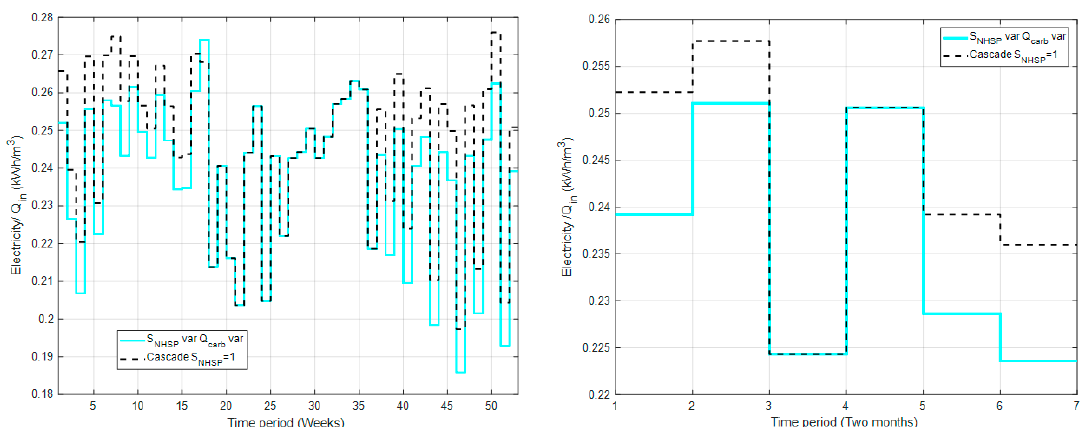
Figure 11. Weekly and bimonthly profile for electricity consumption indicator (kW h/m 3 ) with Cascade S NHSP and the alternative strategy.